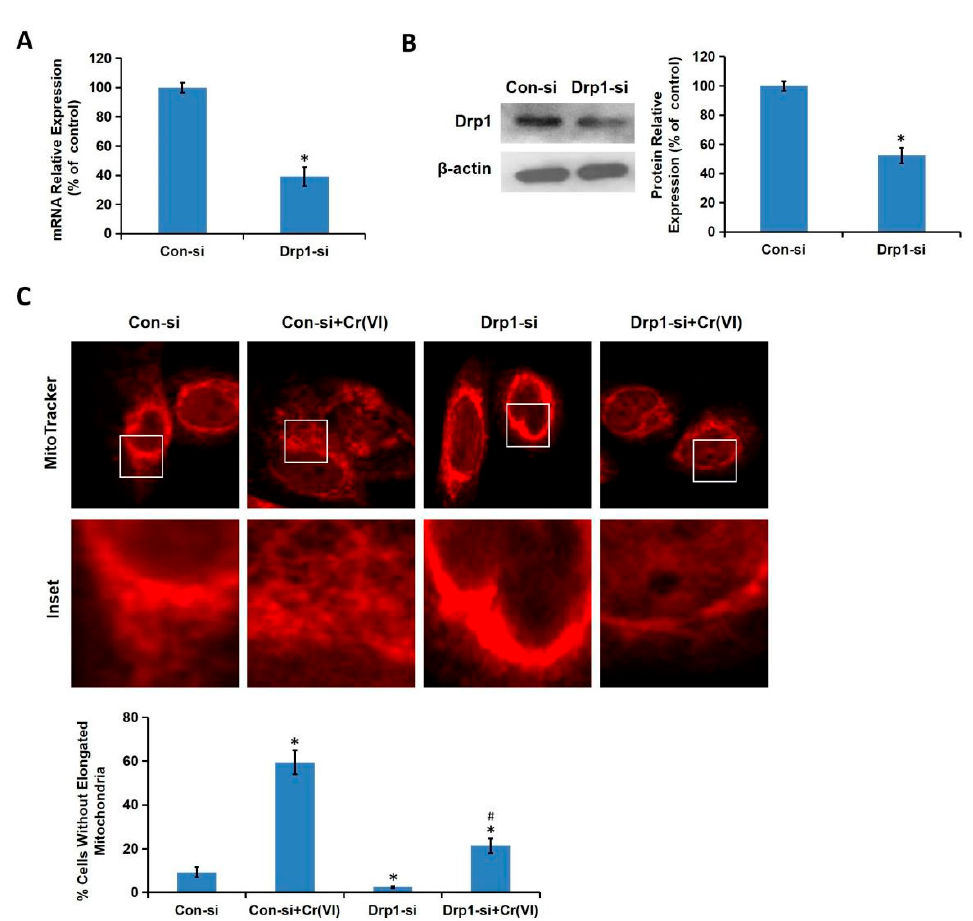
Figure 5. Cr(VI) induced mitochondrial hyper-fission via interfering with Drp1. Drp1 siRNA plasmid was constructed and verified using qRT-PCR ( A ) and Western blotting ( B ). ( C ) The L-02 hepatocytes transfected with Drp1-siRNA and its control (Con-si) were treated with Cr(VI) (16 µM) or PBS for 24 h. Mitochondrial morphology was determined using Mitotracker Red by confocal microscope. The % of cells without elongated mitochondria was calculated. * p < 0.05, compared with the control group. # p < 0.05, compared with the Con-si plus Cr(VI) treatment group.